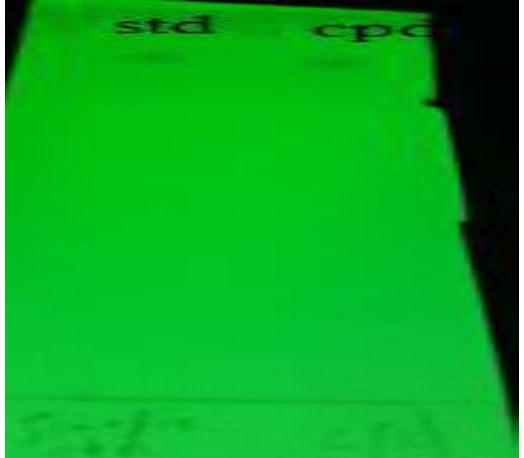
Figure 10. TLC chromatography for isolated compound number (2) from ethyl acetate fraction and S.A standard using silica gel Gf254 as adsorbant and S3 as mobile phase